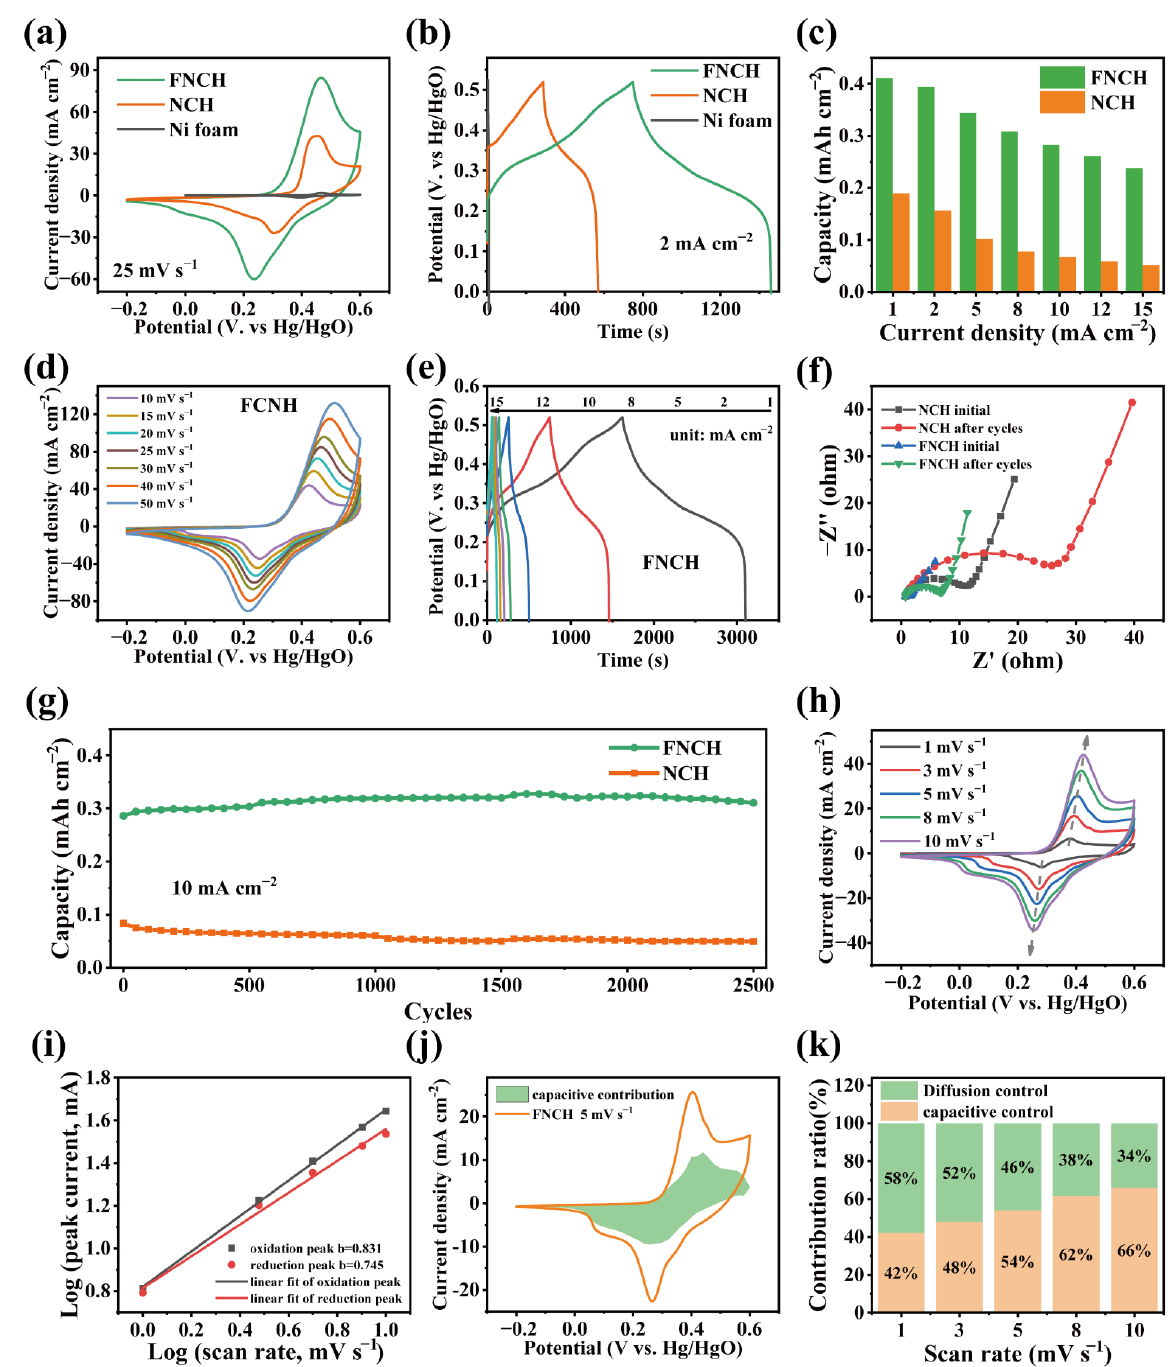
Figure 4. Electrochemical performance tests of FNCH and NCH materials. CV curves ( a ) and GCD curves ( b ) comparisons of FNCH and NCH; ( c ) capacity at various current of FNCH and NCH; ( d ) CV curves and ( e ) GCD curves of FNCH under different conditions; ( f ) Nyquist plot of FNCH and NCH before and after cycles. ( g ) Cycling performance of FNCH and NCH; ( h ) CV curves of FNCH for b value fitting; ( i ) b value fitting result; ( j ) CV curves of origin data and fitting data at 5 mV s −1 . ( k ) Contribution ratio at different scan rates.